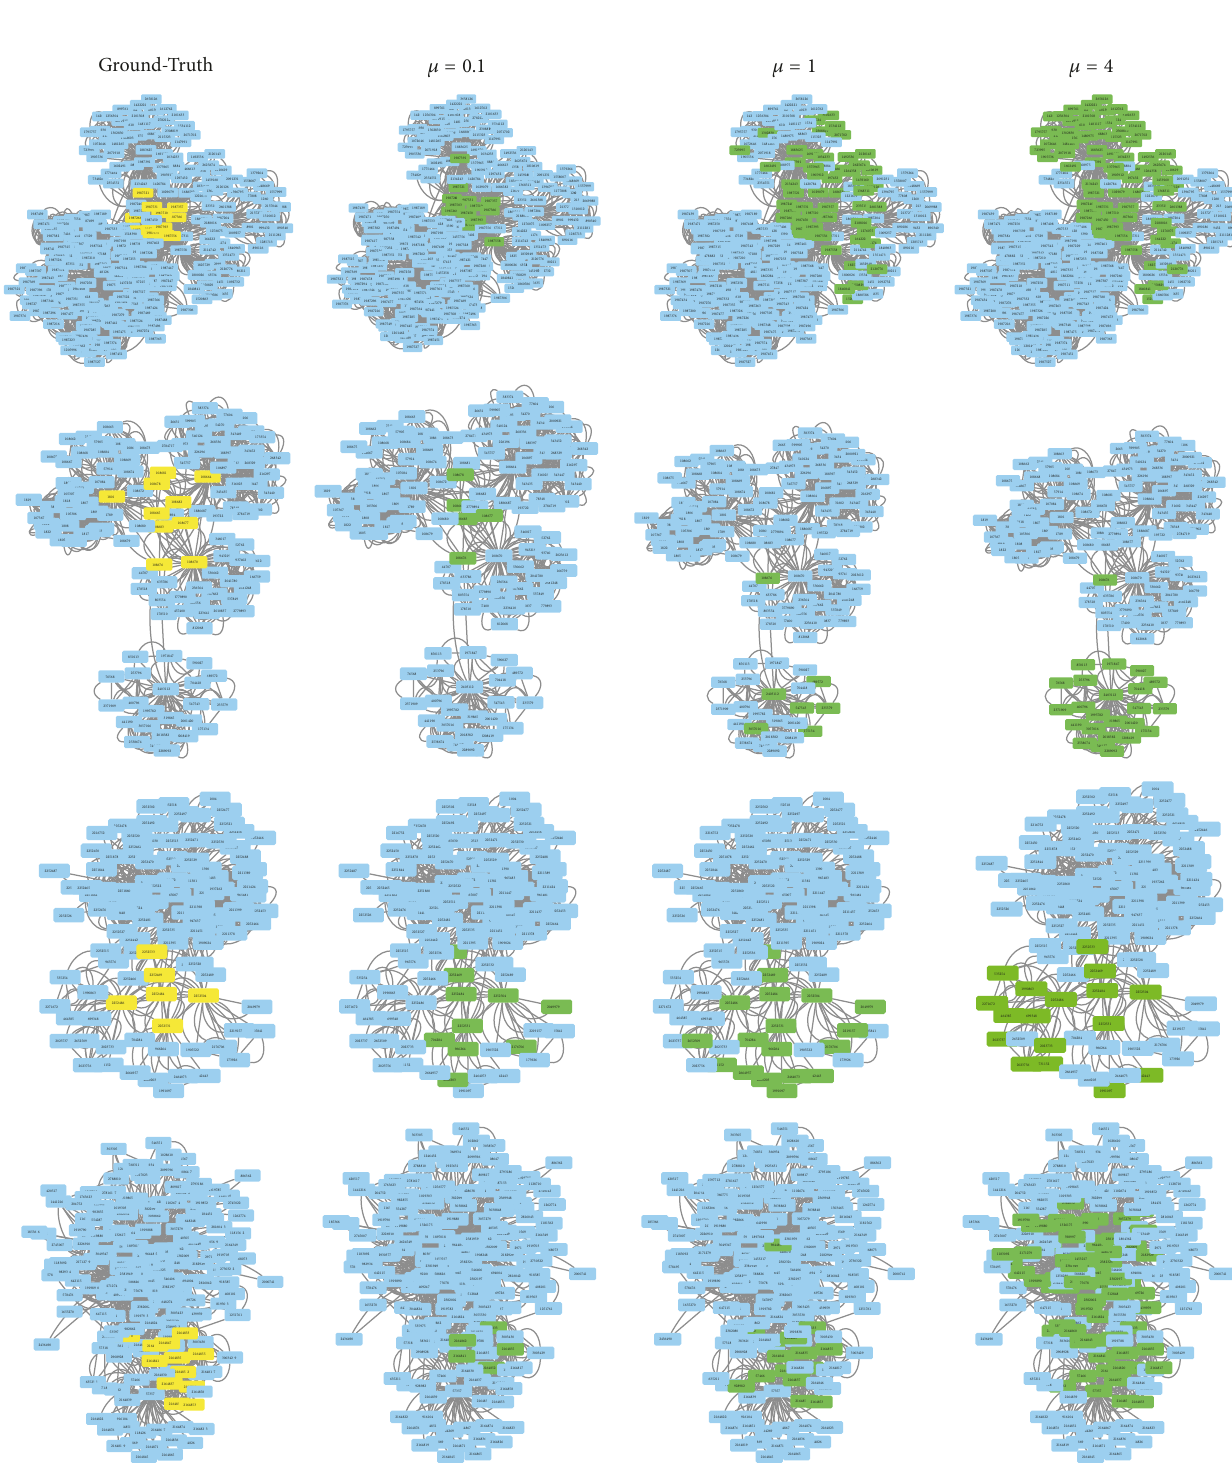
Figure 3: Comparison by varying density parameters on Orkut